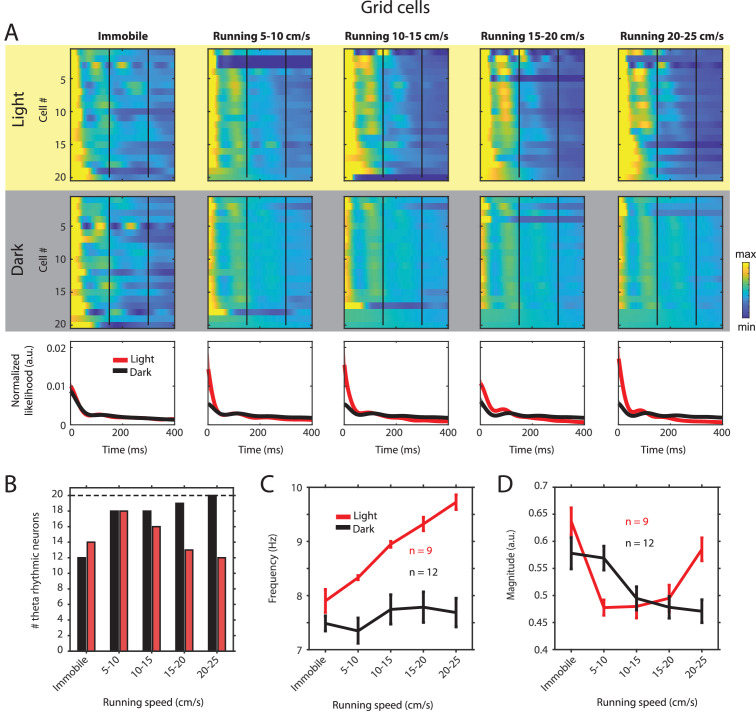
Changes in theta rhythmic firing as a function of running speed and visual inputs in theta rhythmic grid cells.Red color or yellow background indicates data on the light condition, black and gray color or gray background indicates data on the dark condition. (A) Upper panels show the color coded MLE autocorrelogram models for each of n = 20 theta rhythmic grid cells at different running speed intervals. Immobility was defined as running speed <3 cm/s. Neurons are sorted per condition in order of their theta rhythmic firing frequency. Bottom row shows the average across autocorrelogram models per condition. (B) Number of neurons shown in A with statistically significant spiking rhythmicity at alpha = 0.1 determined by the MLE model for different running speeds in light and dark. (C, D) Longitudinal analysis of frequency (C) and magnitude (D) of theta rhythmic firing of neurons with significant theta rhythmic firing across all running speed bins (light: n = 9 neurons; dark: n = 12 neurons). Data show mean ± s.e.m. As shown for all principal neurons (Figure 2—figure supplement 2 and Tables 1 and 2), the frequency of theta rhythmic firing increased as a function of running speed during the light condition (slope = 0.0928, CI = [0.0461 0.1395], t = 4.0058, df = 43, p=0.0002, linear mixed effects model) but not during the dark condition (slope = 0.0168, CI = [–0.0265 0.0601], t = 0.7764, df = 58, p=0.4407, linear mixed effects model), and the difference between slopes in light and dark conditions was significant (slopeLight–Dark = –0.0760, CI = [–0.1385 –0.0135], t = –2.4125, df = 101, p=0.0176, linear mixed effects model). In contrast, the magnitude of theta rhythmic firing did not change as a function of running speed during the light condition (slope = –0.0017, CI = [–0.0091 0.0057], t = –0.4669, df = 43, p=0.6430, linear mixed effects model). The magnitude of theta rhythmic firing decreased slightly as a function of running speed during darkness (slope = –0.0061, CI = [–0.0120 –2.0430], t = –2.0710, df = 58, p=0.0428, linear mixed effects model) but the slope during darkness was not significantly different from the slope in the light condition (slopeLight–Dark = –0.0044, CI = [–0.0136 0.0049], t = –0.9399, df = 101, p=0.3495, linear mixed effects model).